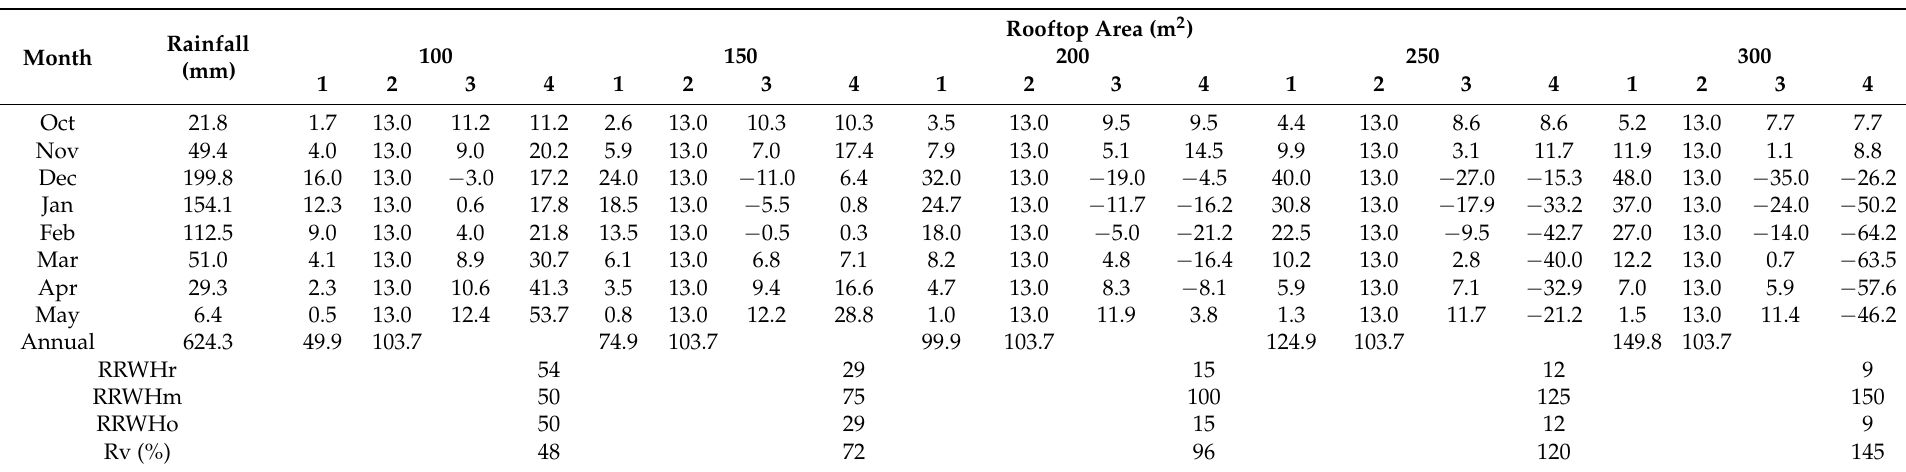
Table 4. RRWHo calculations for Nablus governorate for the different rooftop areas for the S2